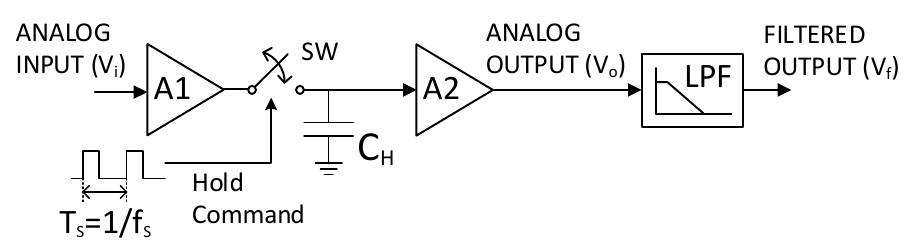
Figure 5. The basic scheme of an SH circuit.